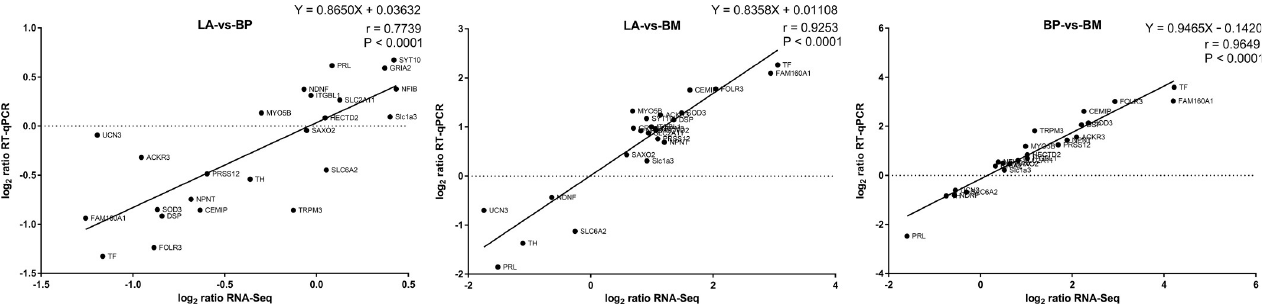
Fig 3. Validation of the gene expression profile by qPCR. Plot of gene expression log2 ratios (LA vs BP, LA vs BM and BP vs BM) determined by the RNA-Seq (X-axis) and RT-qPCR (Y-axis) for 24 selected genes (S6 Table). Correlation between RNA-Seq and RT-qPCR was calculated by Pearson product moment correlation in pairwise comparisons of three stages. Each dot represents one tested gene and the plots present linear regression lines, P values and correlation coefficients (r).